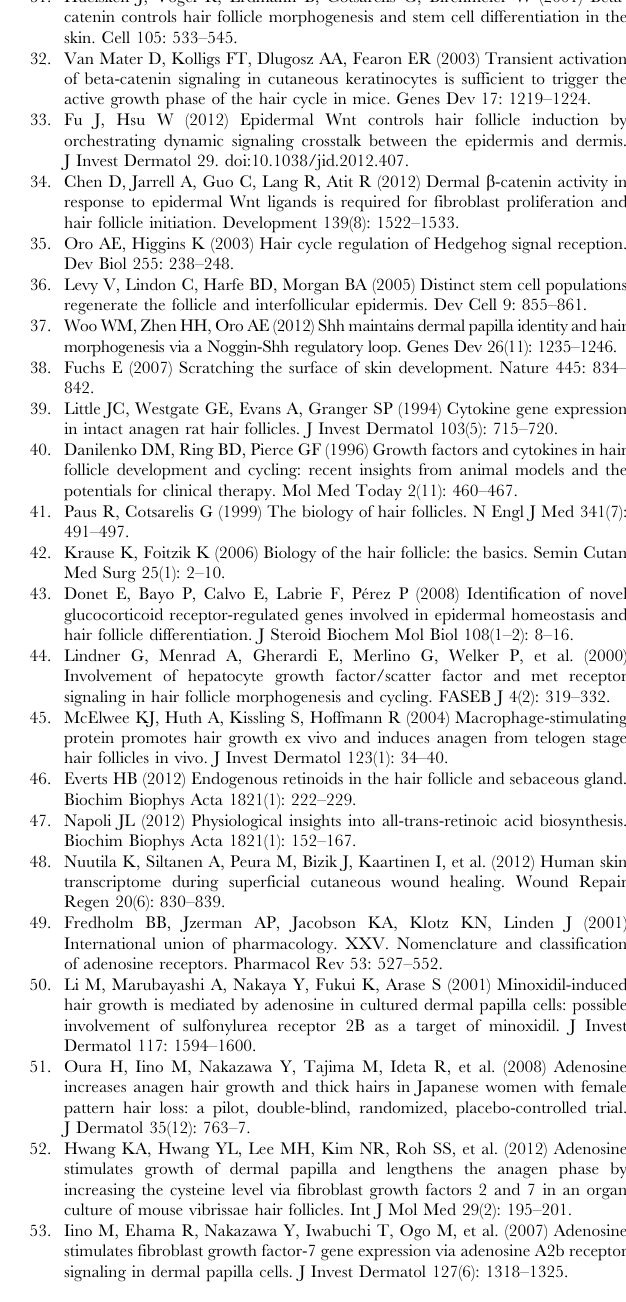
Table S3 Differentially expressed genes between cata- gen and telogen. Table S4 A list of GO categories for DEGs between different developmental